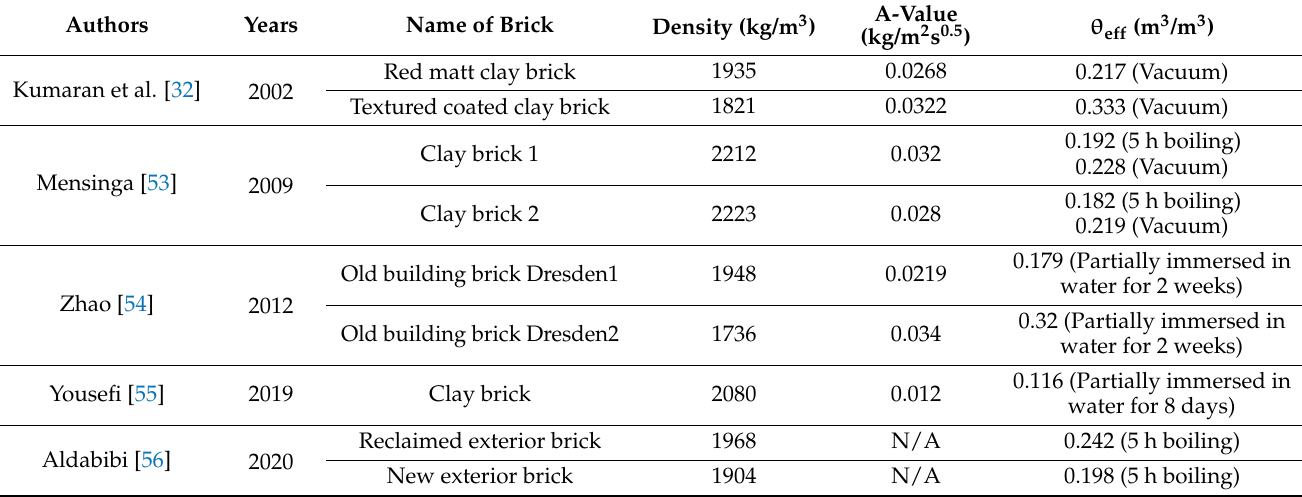
Table 7. Literature review on A-value and effective saturation water content of brick.